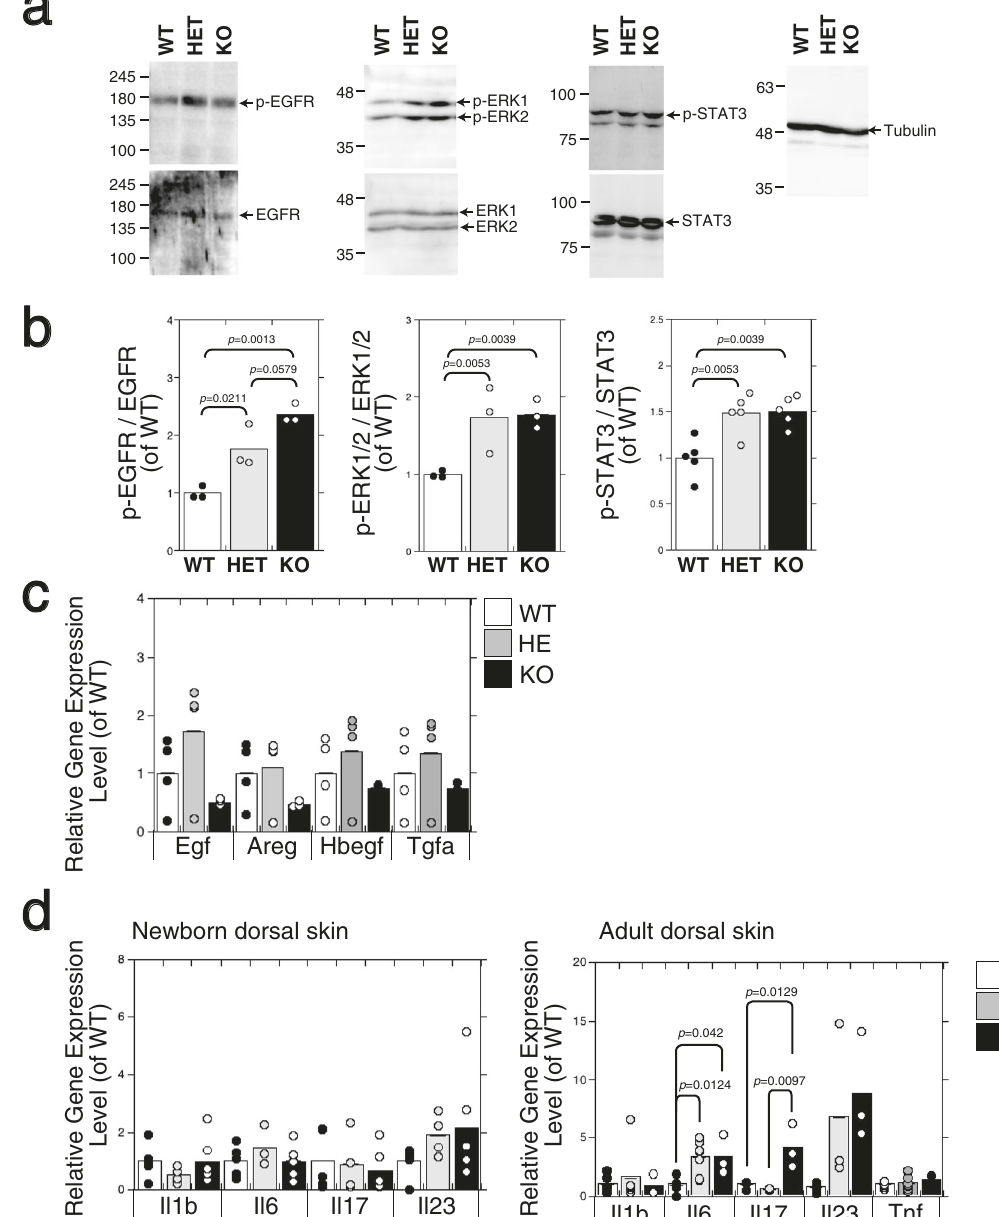
Fig. 4 The expression of phospho-EGFR, phospho-ERK1/2, and phospho-STAT3 is augmented in the epidermis of C6st-1 HE and C6st-1 KO mice compared with that in C6st-1 WT mice. a Proteins extracted from the epidermis of newborn C6st-1 WT, C6st-1 HE, and C6st-1 KO mice were analyzed by immunoblotting using anti-phospho-EGFR (p-EGFR), anti-EGFR, anti-phospho-ERK1/2 (p-ERK1/2), anti-ERK1/2, and anti-phospho-STAT3 (p-STAT3), anti- STAT3, and anti-tubulin antibodies. b Densitometric analysis of the levels of phospho-EGFR, phospho-ERK1/2, and phospho-STAT3 compared with levels of total EGFR, ERK1/2, and STAT3 is shown. Bars represent the means ± S.D. from three independent biological replicates. Statistical signi fi cance was determined using one-way ANOVA with Tukey ’ s HSD test. c The expression levels of EGFR ligands ( Egf, Areg, Hbegf, and Tgfa ) in C6st-1 WT, C6st-1 HE, and C6st-1 KO keratinocytes were analyzed using real-time PCR ( n = 4). Values are mean ± S.D. d Expression levels of pro-in fl ammatory cytokines ( Il1b, Il6, Il17 , and Il23 ) in dorsal skin of C6st-1 WT, C6st-1 HE, and C6st-1 KO newborn and adult (13-week-old) mice were analyzed using real-time PCR ( n = 3 – 7). Values represent the mean ± S.D. Statistical signi fi cance was determined using one-way ANOVA with Tukey ’ s HSD test.